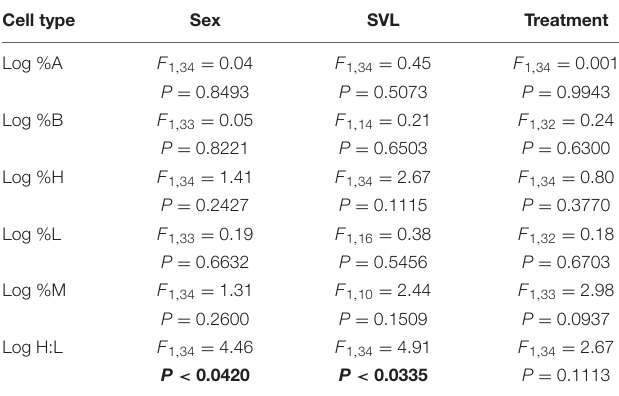
provided by the shell. Again, however, we saw no significant immune response in WBC counts of